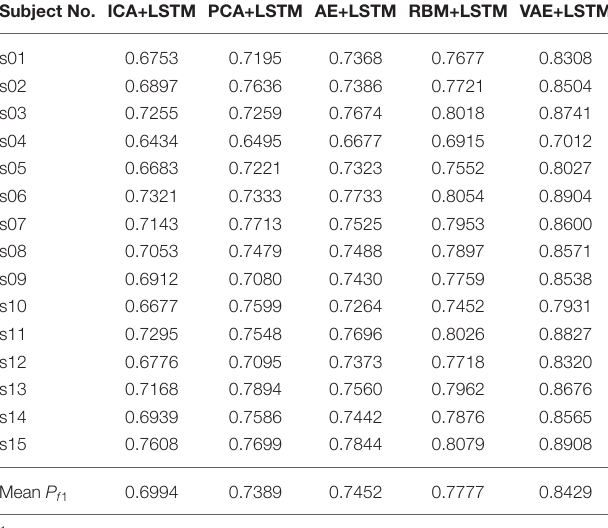
TABLE 4 | Recognition performance on subject data of SEED dataset.